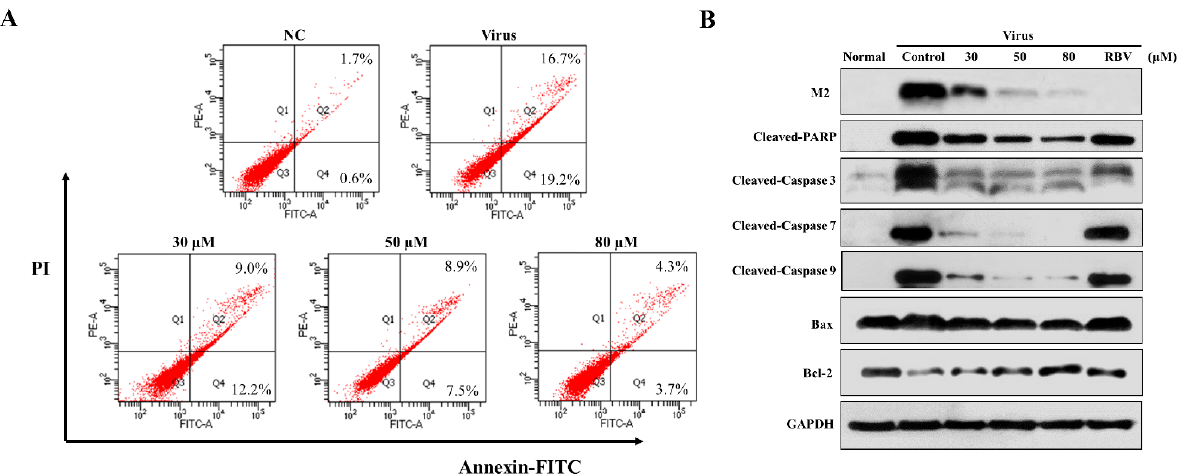
Figure 4. Effect of 3D on apoptosis induced by H1N1. A549 cells were mock-infected or infected with A/Weiss/43 H1N1 and treated with 3D (30, 50, and 80 µM) for 24 h. ( A ) Apoptosis was analyzed by flow cytometry using Annexin V-FITC/PI staining. ( B ) Cell lysates were collected and the indicated proteins were detected by western blot assay. For positive control, the indicated cells were treated with ribavirin (100 µM).